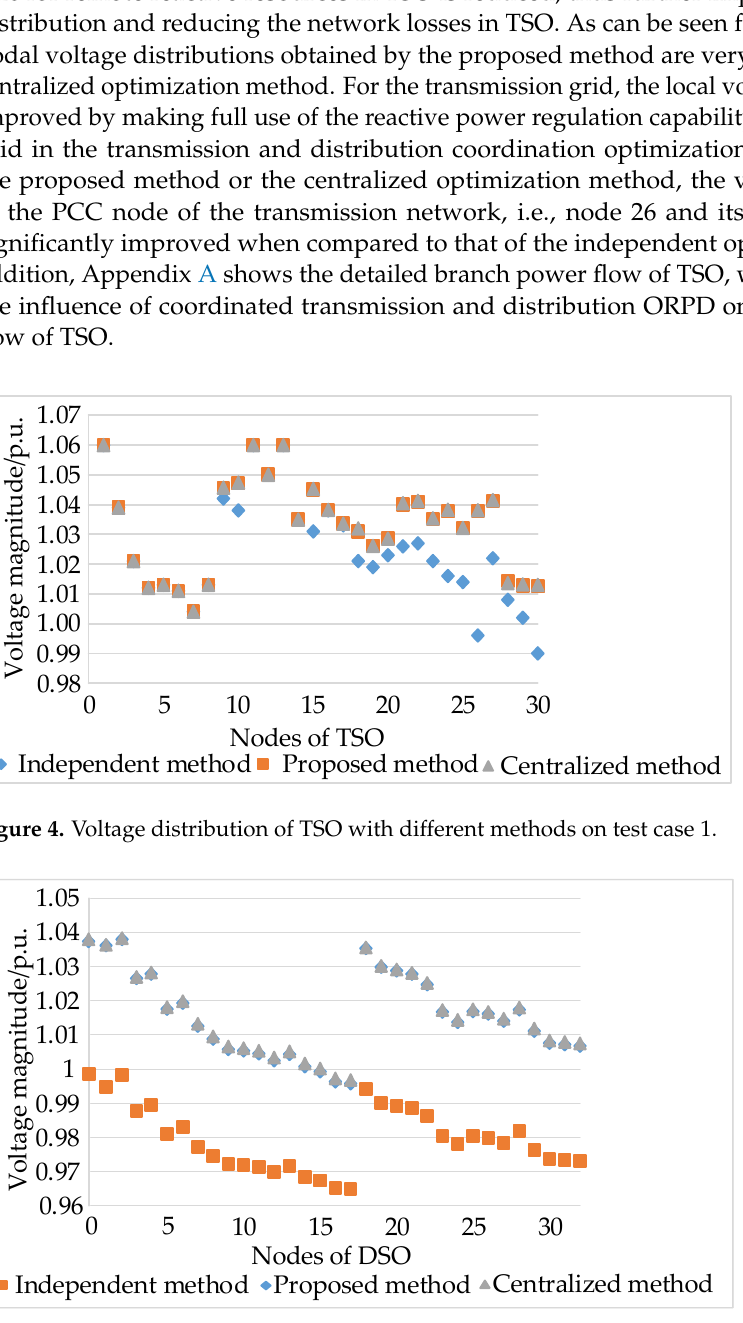
Table 6. Reactive power output of DGs in D26 with different methods on test case 1. Independent Method Proposed Method